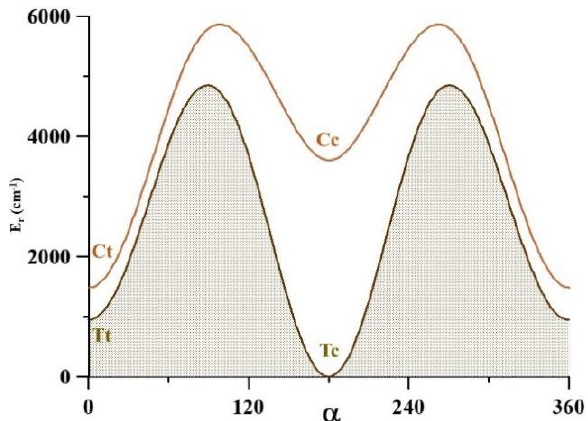
Figure 4. The CCSD(T)-F12 V OH torsional barriers. The Tc → Tt and Ct → Cc pathways were computed using the θ 1 and θ 2 values of the Tc and Ct conformers, respectively.